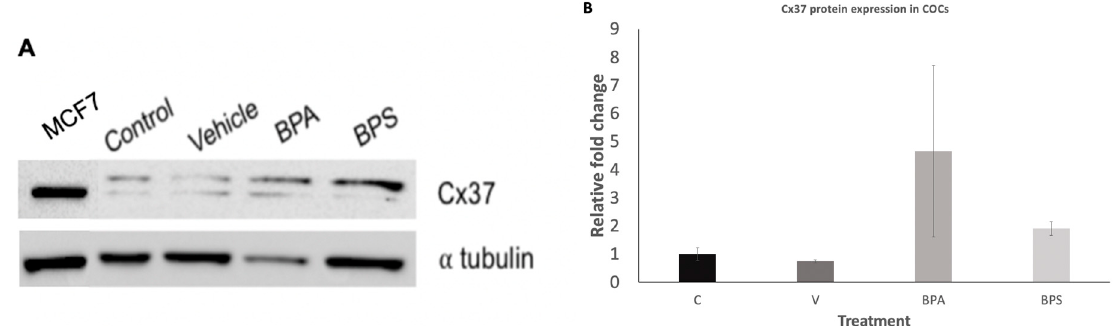
Figure 5. Connexin protein expression in bovine COCs. ( A ) Western Blot showing protein expression of Cx37 after 24-h maturation in SIVM (control), S-IVM with 0.1% ethanol (vehicle), S-IVM + 0.1% 0.05 mg/mL BPA (BPA), and S-IVM + 0.1% 0.05 mg/mL BPS (BPS). a tubulin: loading control. ( B ) Densitometry analysis for 3 biological replicates, depicting the relative fold change of Cx37 protein expression for treatment groups as compared to the control. Results showed an 8.14-fold increase in BPA group. Letters indicates statistical significance at p < 0.05, BPA ( p = 0.0418, n = 3).